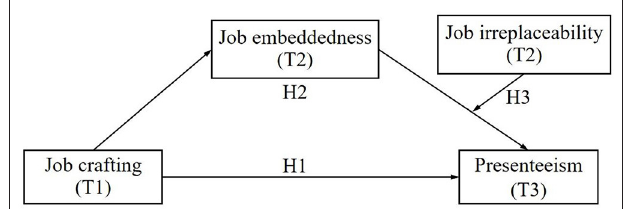
FIGURE 1 | Hypothesized conceptual